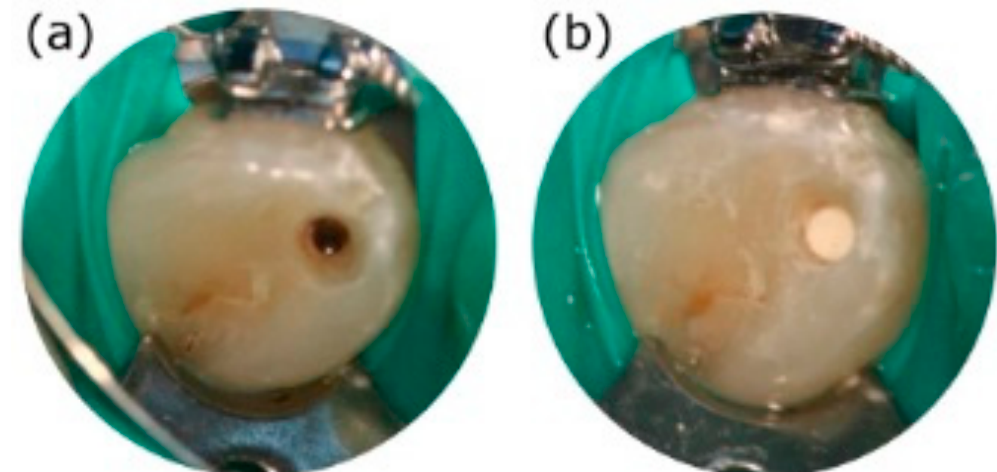
Figure 4. Microscopic photos during the treatment procedure. ( a ) The “pseudo-canal” was accurately located under the microscope at a magnification of X9.6 to avoid excessive dental tissue loss. ( b ) Dense mineral trioxide aggregate was filled-in after thorough debridement.